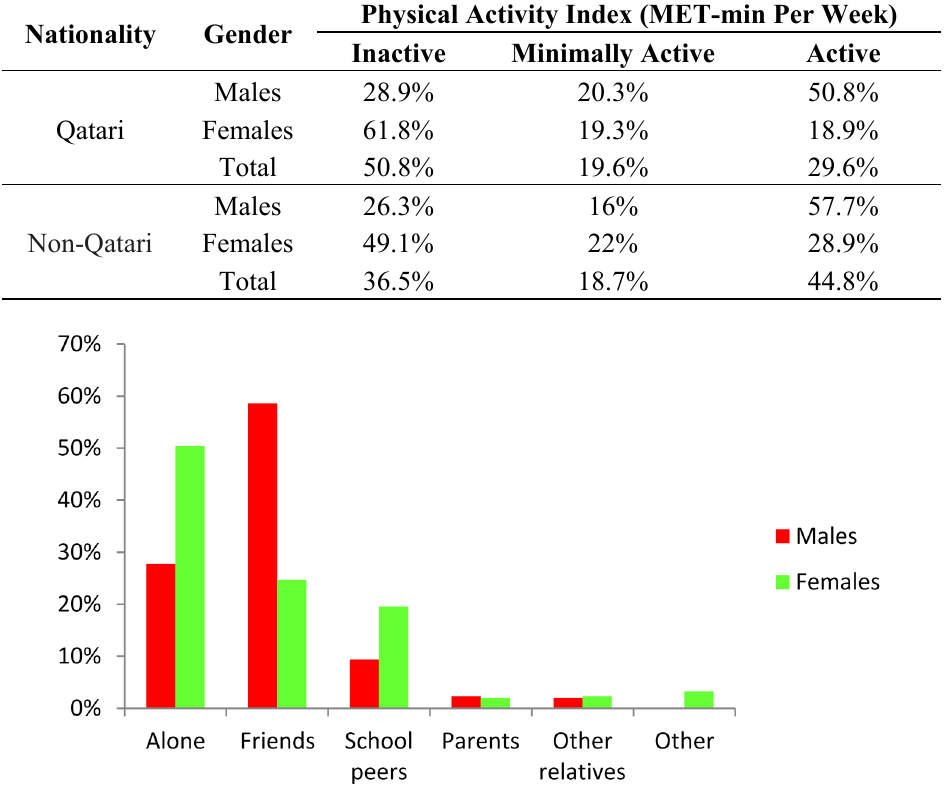
Figure 2. Responses of male and female students as to whom they engage with in physical activities or